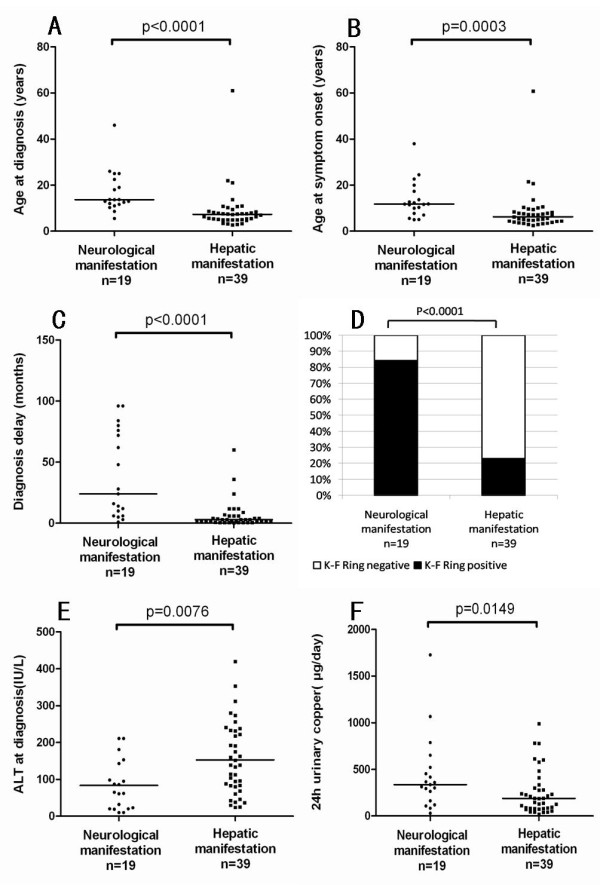
Correlation of clinical manifestations with age at diagnosis (A), age at symptom onset (B), diagnostic delay (C), corneal Kayser-Fleischer rings (D), alanine transaminase levels at diagnosis (E) and 24-h urinary copper excretion at diagnosis (F) in Chinese patients with Wilson's disease.